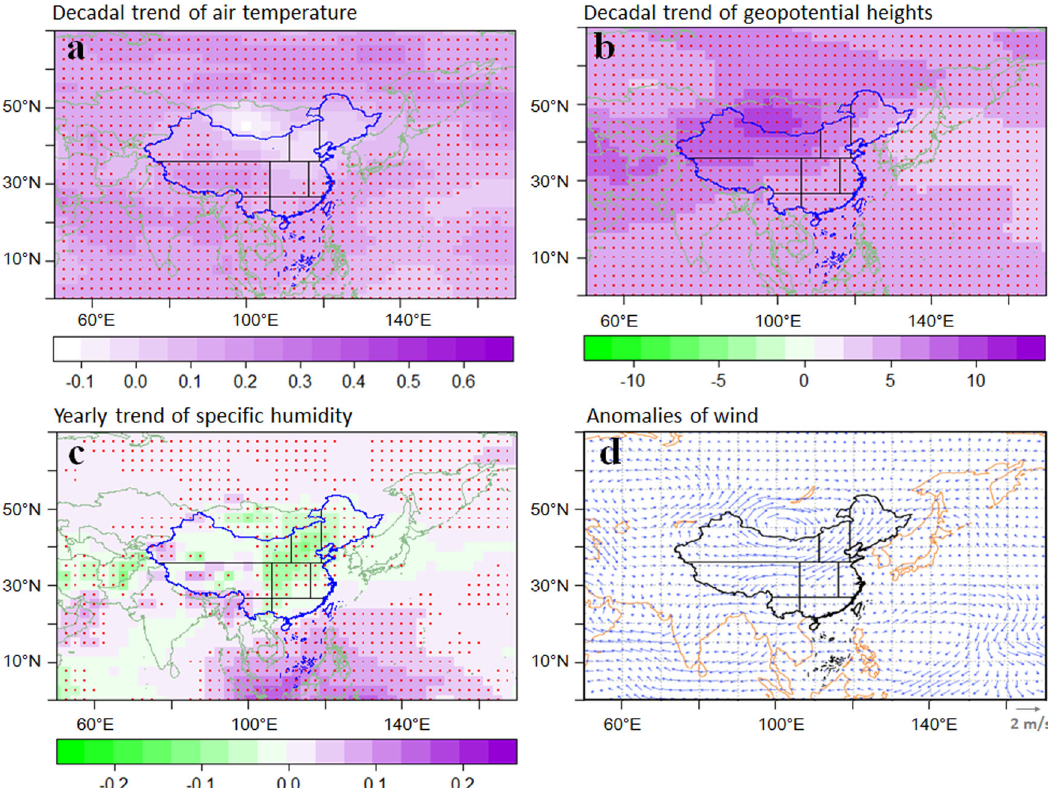
Fig. 8 Maps of changes in the atmospheric variables. Spatial distribution of the decadal trend of a air temperature and b geopotential height at 500 hPa from 1960 to 2018. c Spatial distribution of the yearly trend of speci fi c humidity for 300 – 1000 hPa from 1960 to 2018. d The anomalies in wind at 500 hPa between the period 1991 – 2018 and 1960 – 1990. Areas with red dots indicate 95% signi fi cance. The sub fi gures were done in the software R 4.0.2 (https://cran.r-project.org/bin/windows/) and then the sub fi gures were merged by using the Microsoft PowerPoint 2013 software